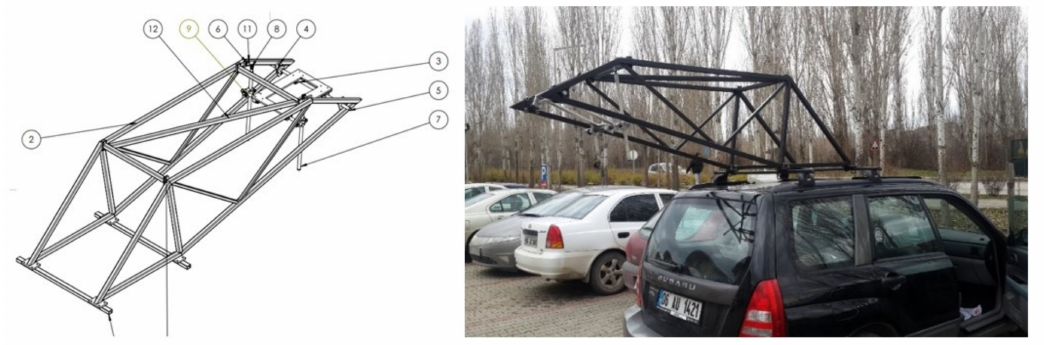
Figure 8. The metal platform for camera connection and its position mounted on the